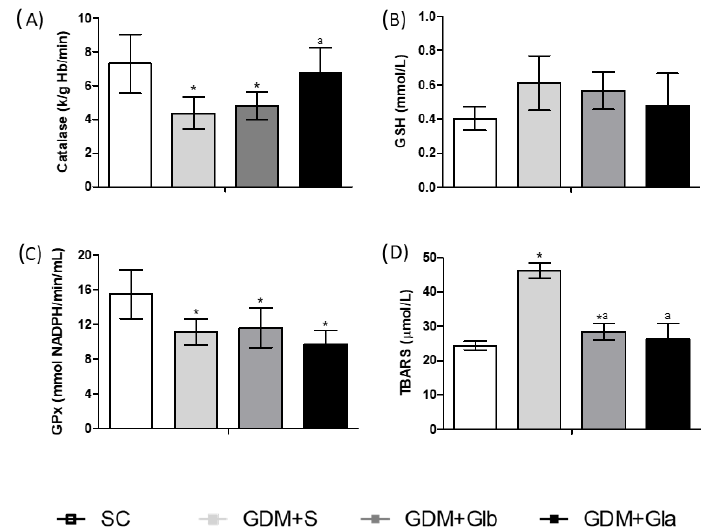
Figure 3. Oxidative stress of pregnant rats. GDM-STZ treated with Ganoderma lucidum . SC (0.9% saline solution), GDM+S (Diabetic+saline solution 0.9%), GDM+Glb (Diabetic + 100 mg/kg/day of Ganoderma lucidum from gestation day 1 to 19), GDM+Gla (Diabetic + 100 mg/kg/day of Ganoderma lucidum from gestation day 9 to 19). ( A ). Catalase (CAT), ( B ). reduced glutathione (GSH), and ( C ). glutathione peroxidase reduction (GPX), ( D ). Thiobarbituric acid reactive substances (TBARS). Data are presented as mean ± SD ( n = 6). (*) p < 0.05 in comparison to SC group, (a) in comparison to the GDM+S group. One-way ANOVA, followed by Tukey–Kramer’s